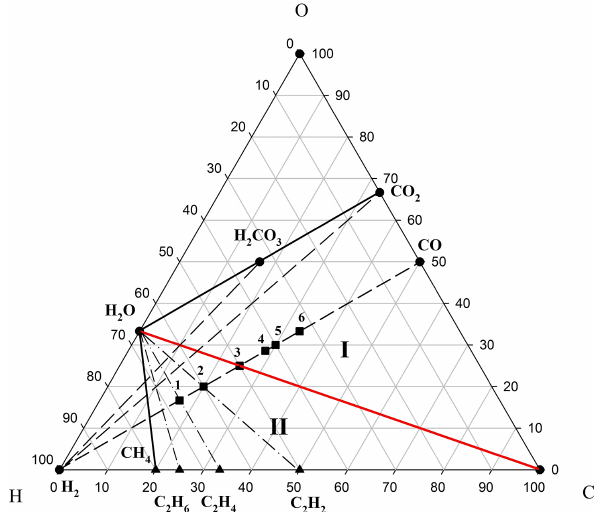
Figure 1. Two regimes of evolution of the C–H–O system on the phase diagram of its compositions. Roman numerals denote vari- ous regimes of hydrogen fluid evolution: (I) water-carbonate and (II) water–hydrocarbon solutions, separated by H 2 O–C equilibrium (red). Parageneses (assemblages) of the initial substances (H 2 , CO and CO 2 ) are denoted by dashed sub-lines, while dashed–dotted lines indicate the parageneses (C 2 H 6 –H 2 O, C 2 H 4 –H 2 O, etc.) of hydrocarbons (black triangles) with water. Black squares denote or- ganic substances within the two component (H 2 –CO) subsystem: methanol (1), ethylene glycol (2), acetate (3), succinate (4), pyru- vate (5) and fumarate